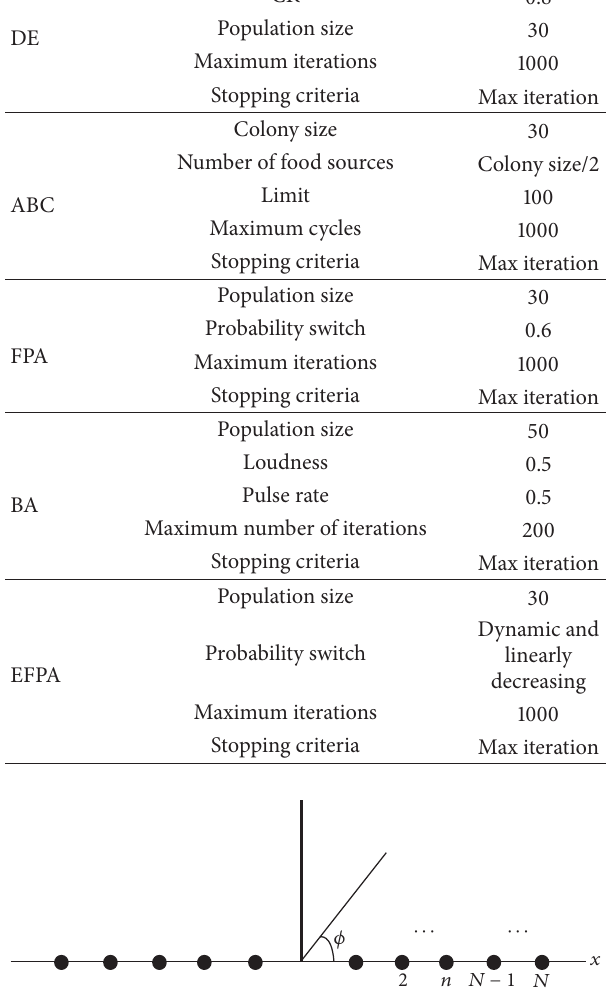
Figure 1: Geometry of a linear antenna